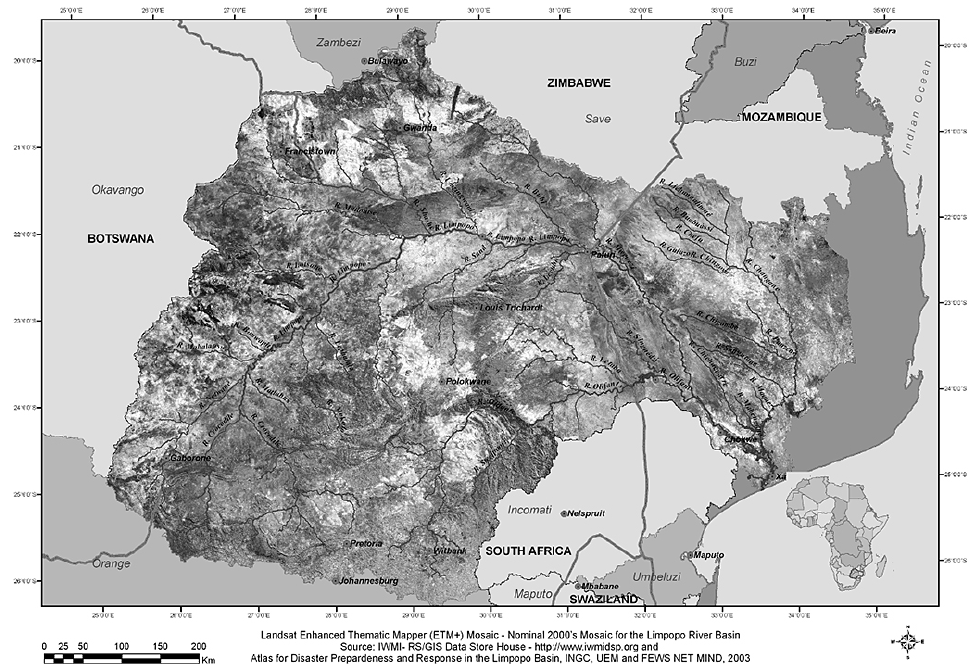
Figure 1. Satellite image mosaic of the Limpopo River basin by collating Landsat satellite images of 30m resolution (source: Maló and Da Conceição, 2007).